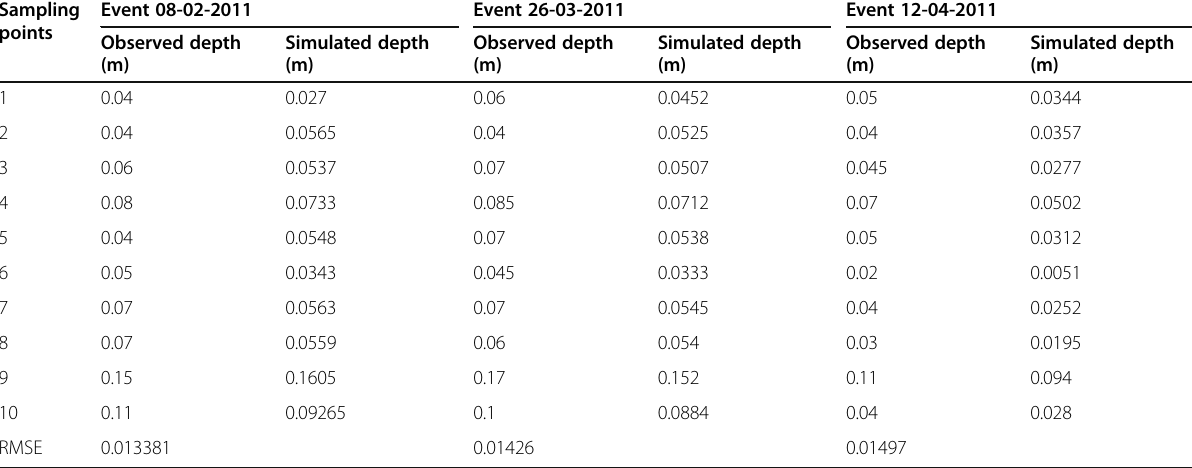
Table 5 The Observed and Simulated depth for the HEC-RAS validation Sampling